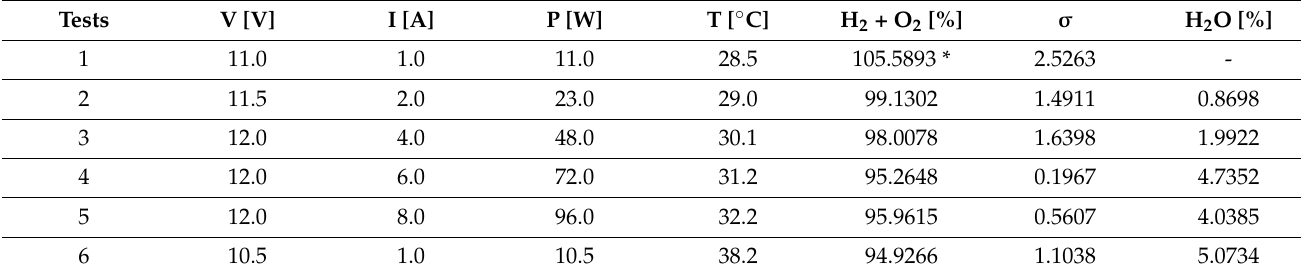
Table 4. Sum of the molar concentration in % of H 2 and O 2 with 3% ( w/w ) of KOH. The percentage of water is estimated from the deficit of the sum of H 2 and O 2 percentages.